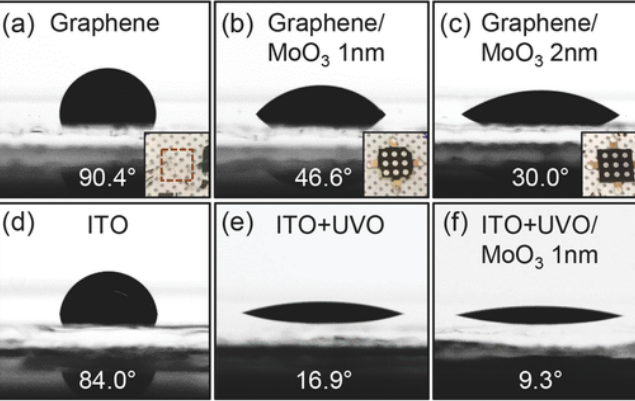
Figure 10. PEDOT:PSS droplet contact angles on ( a ) as-prepared graphene, ( b ) graphene covered with 1 nm MoO 3 , ( c ) graphene covered with 2 nm MoO 3 , ( d ) as-prepared ITO, ( e ) UVO-treated ITO, ( f ) ITO covered with 1 nm MoO 3 after UVO treatment. The insets in ( a – c ) showed the optical images of PEDOT:PSS/MAPbI 3 films fabricated on the corresponding glass/graphene surfaces [74].